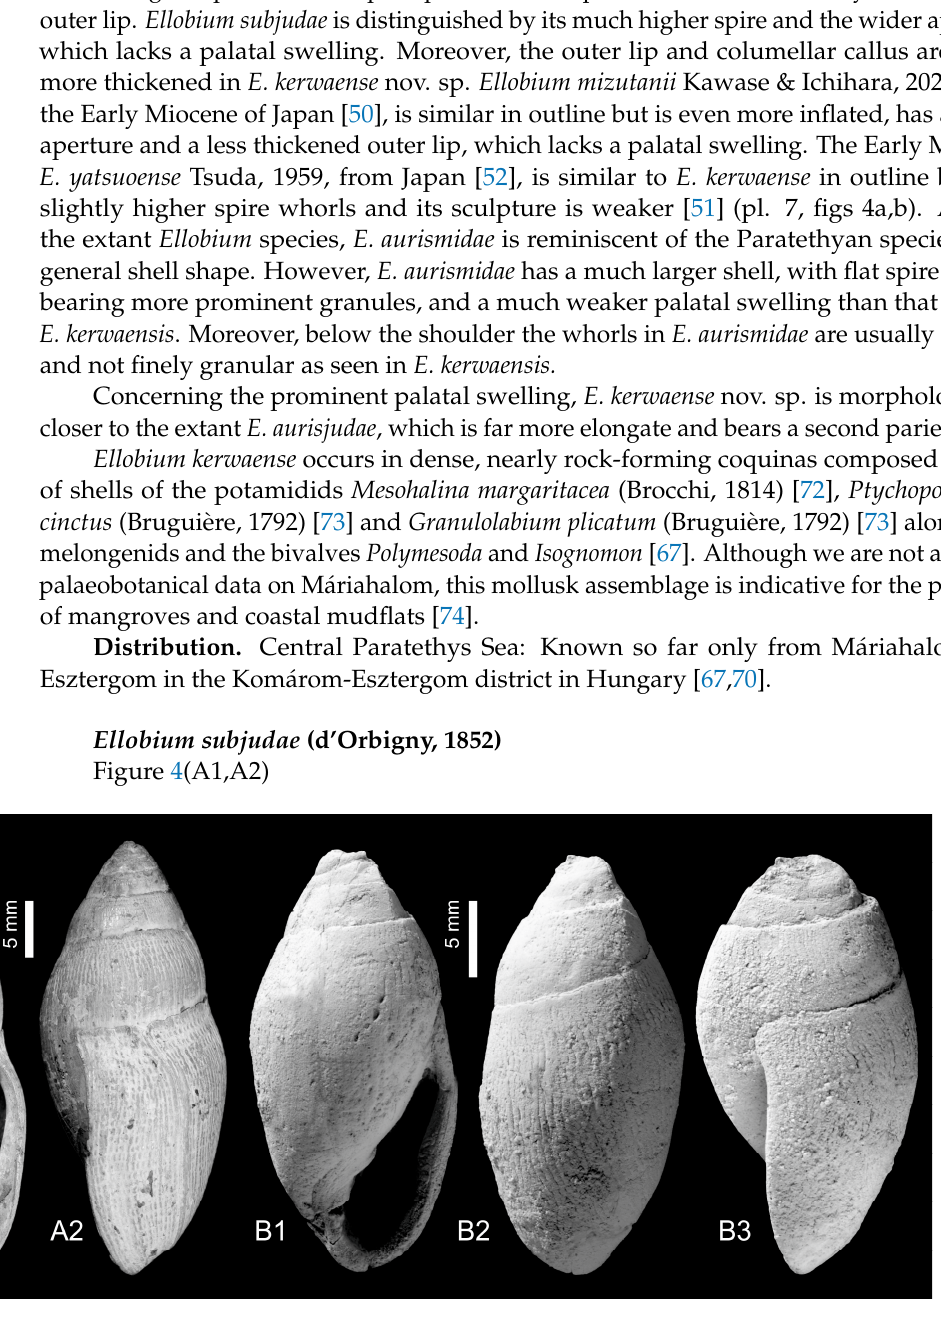
Figure 4. Rupelian (Early Oligocene) Ellobium species: ( A1 , A2 ) Ellobium subjudae (d’Orbigny, 1852), syntype, UB n° 65-2-153 (Grateloup collection), Lesbarritz, Gaas (Landes), France; ( A1 ) apertural view, ( A2 ) lateral view; ( B1 – B3 ) Ellobium vicentinum (Fuchs, 1870), lectotype, NHMW 2022/0286/0001, Soggio di Brin at Salcedo, Vicenza, Italy; ( B1 ) apertural view, ( B2 ) dorsal view, ( B3 ) lateral view. Syntypes. Figure 4(A1,A2), UB n° 65-2-153 (coll. Grateloup), shell height: 37 mm, di-